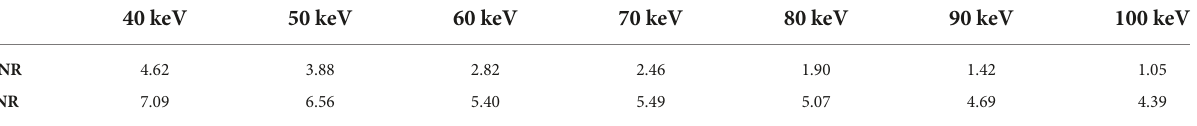
TABLE 2 VMI: quantitative values for CNR and SNR.